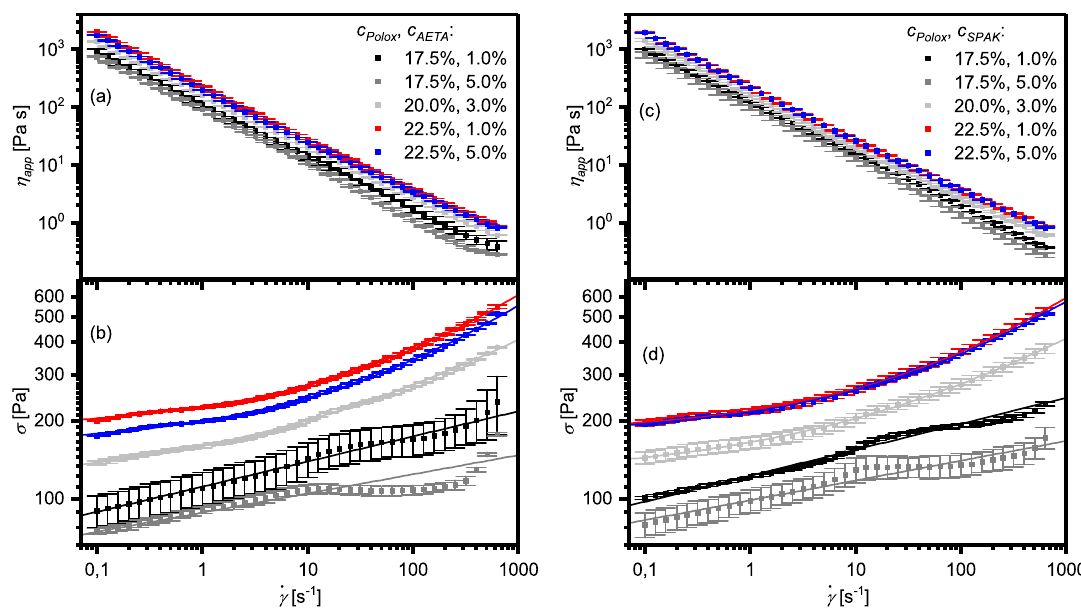
Figure 6. ( a ) Apparent viscosity η app and ( b ) shear stress σ against shear rate ˙ γ of hydrogel formulations containing AETA measured at temperatures 10 K above T gel . ( c ) The apparent viscosity ( η app ) and ( d ) the shear stress ( σ ) versus the shear rate ( ˙ γ ) of hydrogel formulations containing SPAK measured at temperatures 10 K above T gel . In ( b , d ), data belonging to formulations with c Polox ≥ 20% were fitted using Equation (3), and formulations with c Polox = 17.5% were fitted using Equation (1) (for equations see Section 4.2).